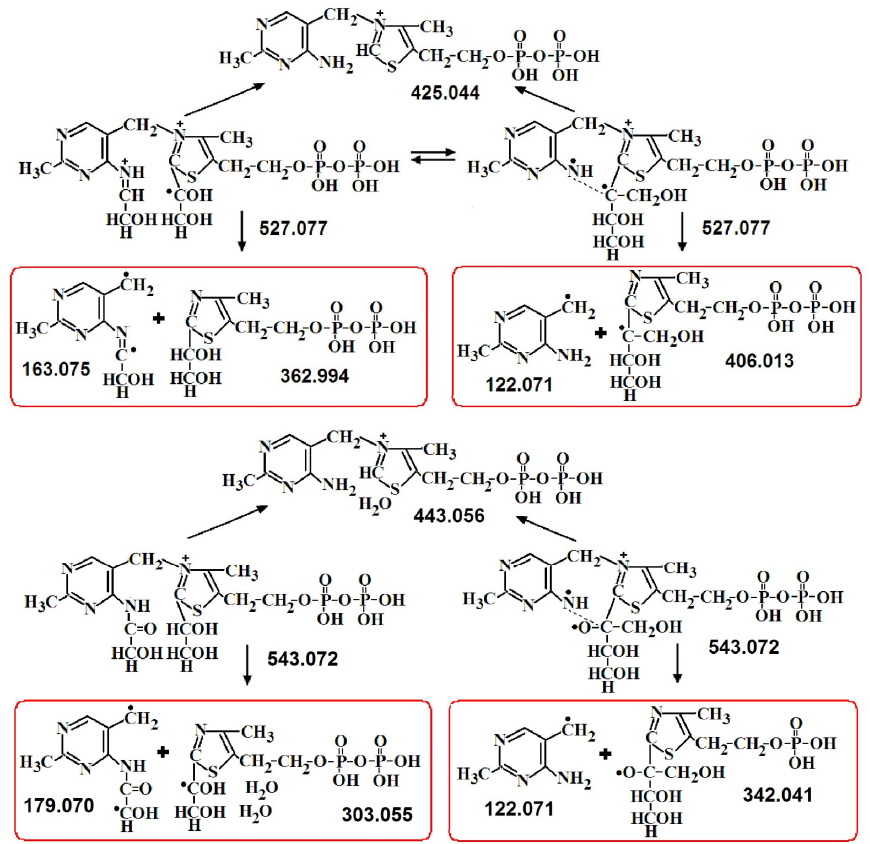
Figure 7. Some proposed fragments of m / z 527.060 and m / z 543.055 [15]. In red boxes are fragments formed when the molecule is broken in half.